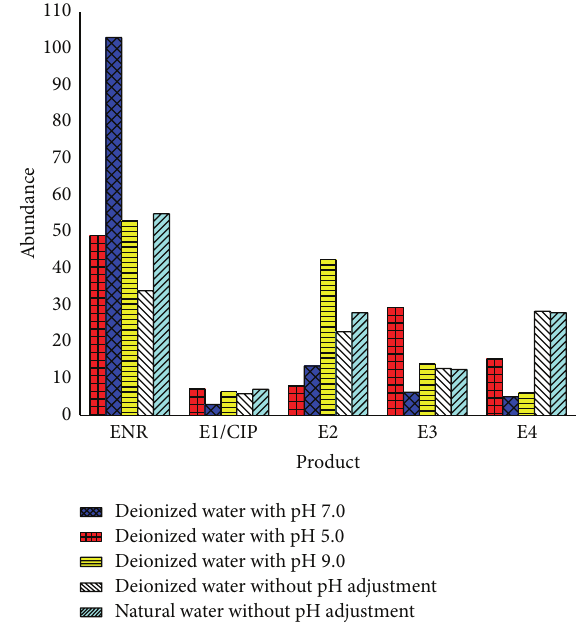
Figure 3: ENR oxidation products relative abundance in deionized waterwithpH5.0,deionizedwaterwithpH7.0,deionizedwaterwith pH 9.0, deionized water without pH adjustment, and natural water without pH adjustment. Experimental condition: [ENR] 0 = 10 𝜇 M, [KMnO 4 ] 0 = 500 𝜇 M, and 𝑇 = 21 ∘